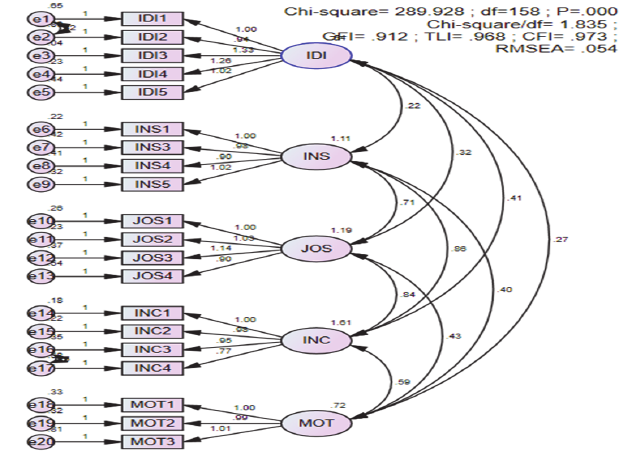
Fig. 2. The result of CFA model